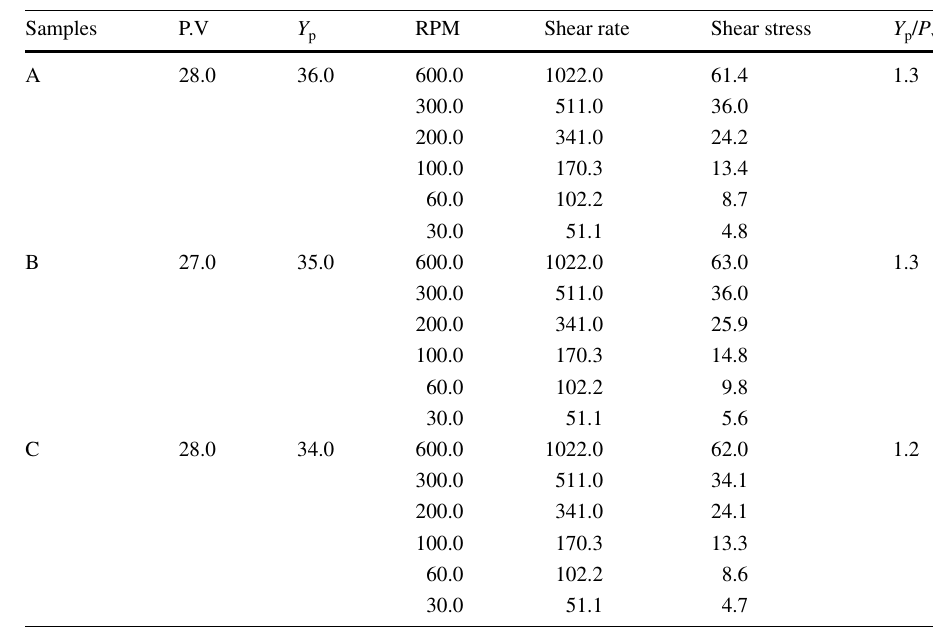
Table 14 Rheology property of